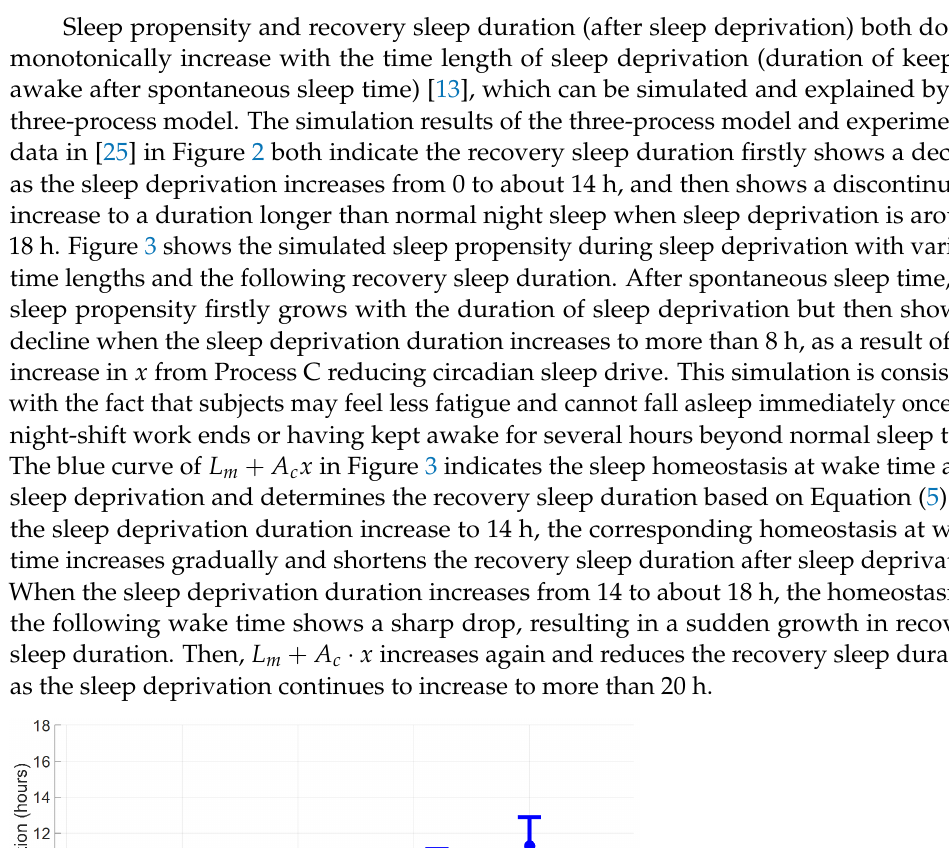
Figure 1. ( Upper panel ) The periodic solution of the three-process model in Equations (1)–(5) and (8) with the reference light input in (11) and spontaneous sleep in (7). ( Lower panel ) The reference light-dark cycle I ref (red region), the corresponding spontaneous sleep schedule (grey region) and the alertness level A ( t ) (blue curve).